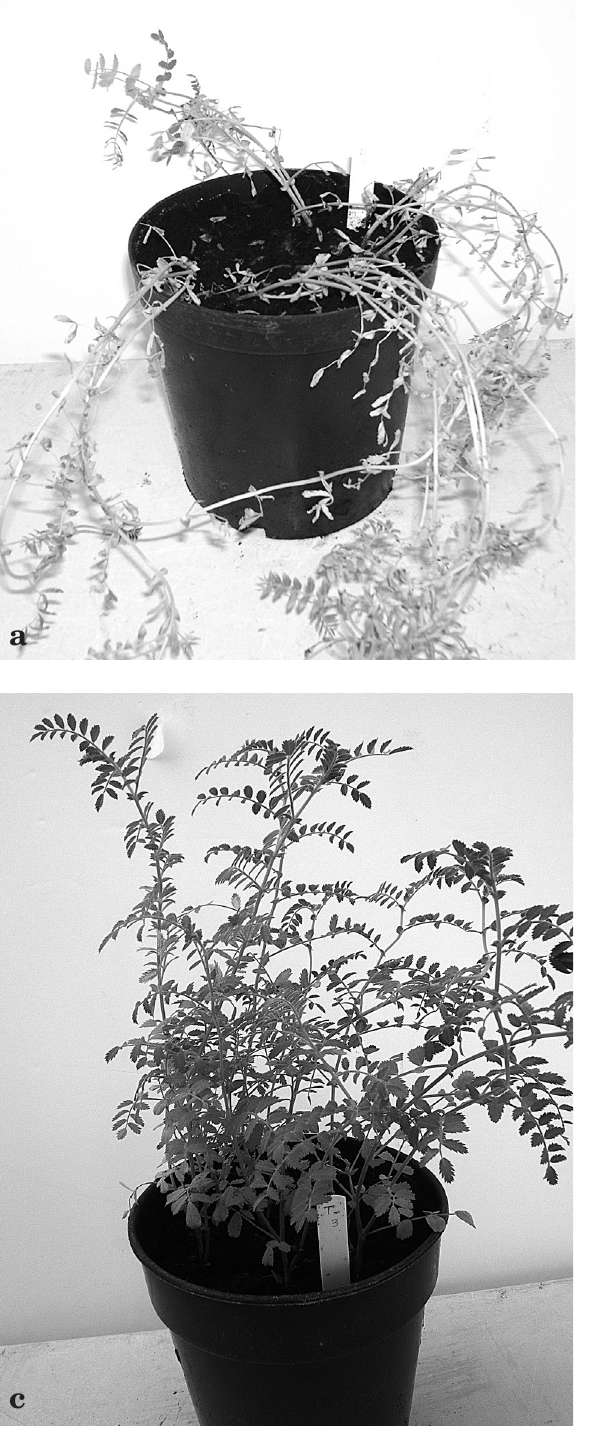
Figure 2. Symptoms caused by inoculating chickpea seedlings with R. solani : a and b, inoculated seedlings showing wilting, yellowing and dark brown lesions on the collar region; c and d, non inoculated